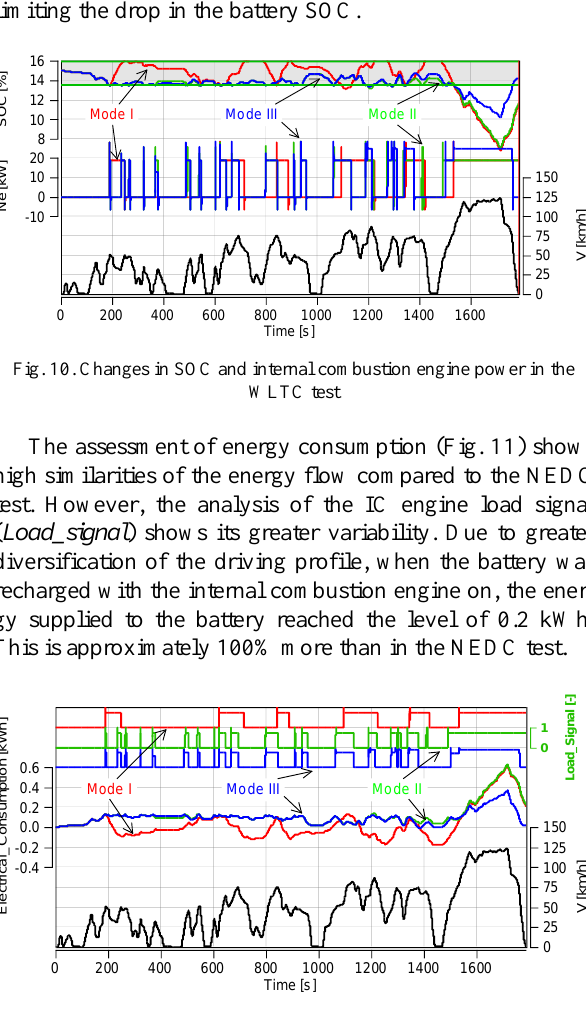
Fig. 11. Internal combustion engine load and electric energy consumption in the NEDC test